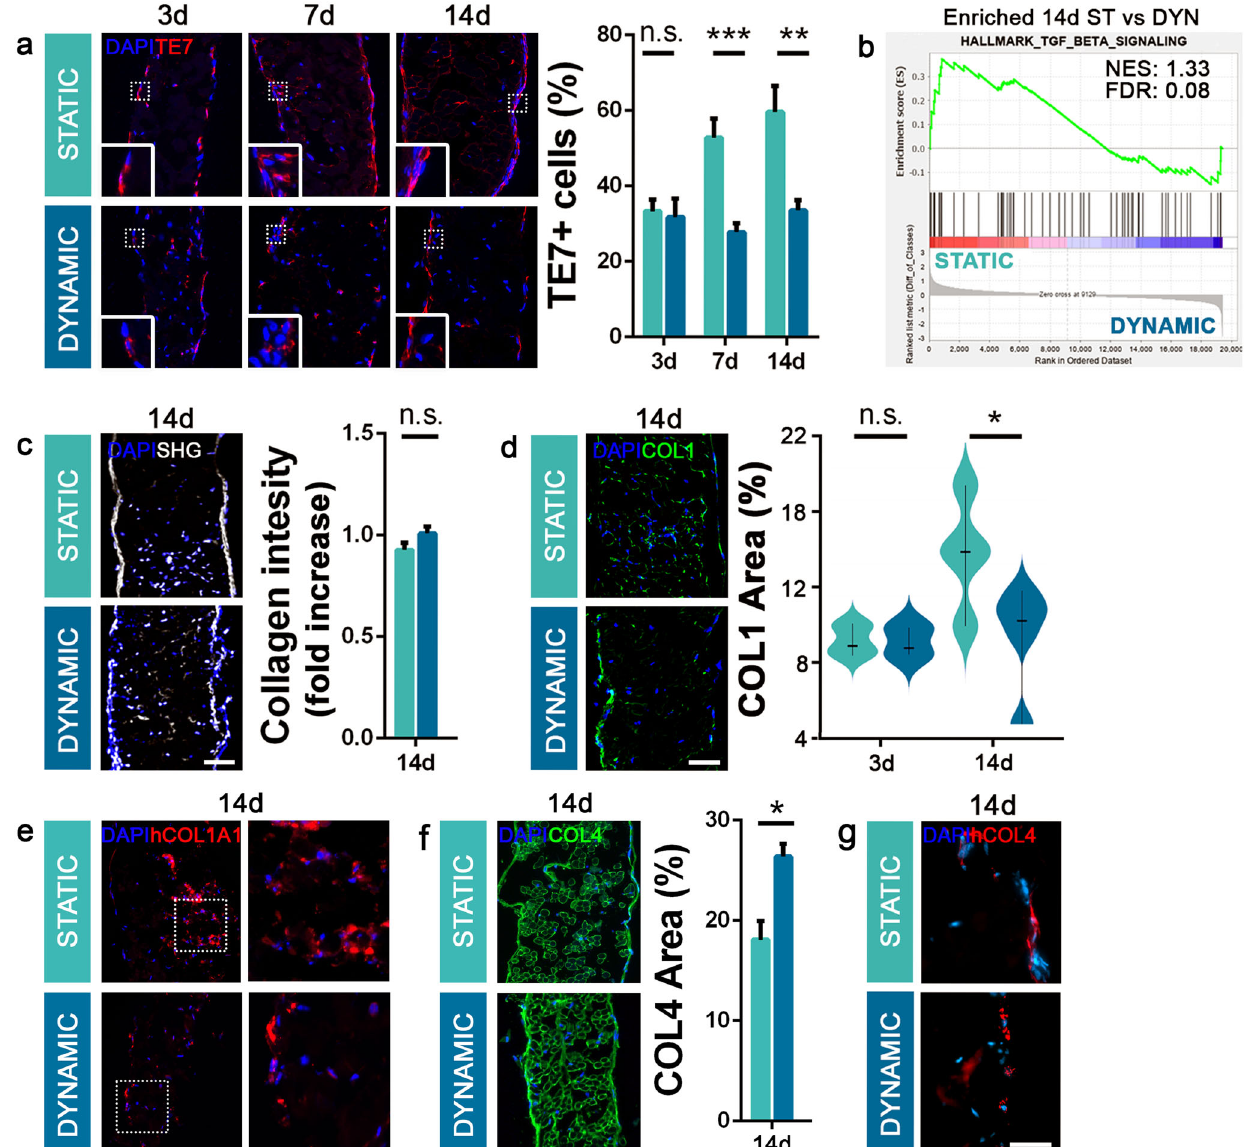
Fig. 4 Diaphragmatic construct remodeling. a Representative immuno fl uorescence images and quanti fi cation of hFb (TE7-positive cells; 10 random high-powered fi elds per sample; mean ± s.e.m.) on static and dynamic samples during the culture period. b Transcriptomic analysis: TGF_beta signaling pathway is enriched in 14-day-cultured static samples. c Representative images of second harmonic generation (SHG) assay on static and dynamic samples after 14 days of culture (mean ± s.d.). d Representative images of Collagen type 1 on static and dynamic samples after 14 days of culture and quanti fi cation at 3 and 14 days (5 random high-powered fi elds per sample, mean ± s.e.m.). e Representative images of human-speci fi c Collagen type 1 on static and dynamic samples after 14 days of culture. f Representative images of Collagen type 4 on static and dynamic samples after 14 days of culture and quanti fi cation at 14 days (5 random high-powered fi elds per sample, mean ± s.e.m.). g Representative images of human-speci fi c Collagen type 4 on static and dynamic samples after 14 days of culture. For each assay, n = 3 per group per each time point. Scale bars: 100 μ m. hCOL4 staining scale bar: 50 μ m. * p < 0.05; ** p < 0.01; *** p < 0.001; n.s. not- signi fi